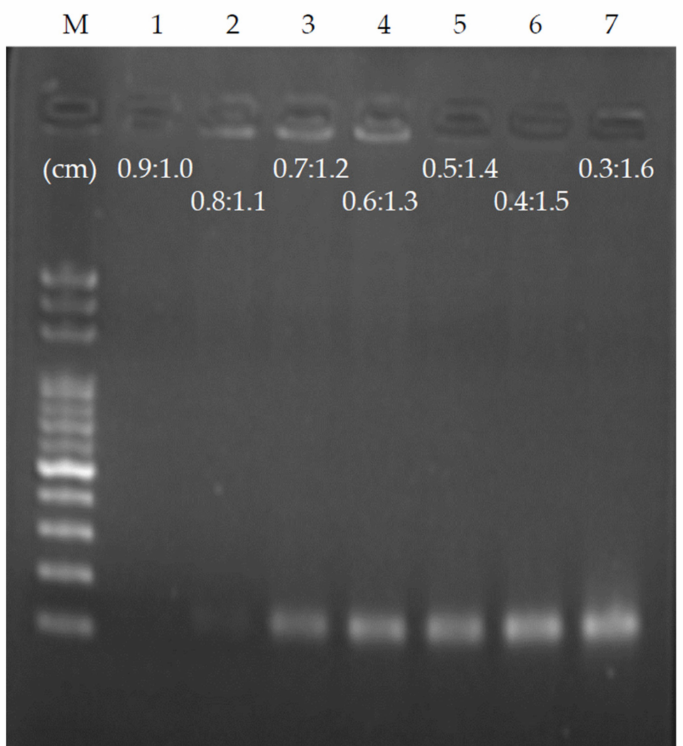
Figure 6. PCR result of changing the length (time) ratio of denaturation and annealing/extension and fixing the flow rate of each 4 s thermal cycle. When the ratio of denaturation and annealing/extension is adjusted to 0.7:1.2, the products appear. The sample residence time of annealing/extension must be sufficient to allow the reaction to